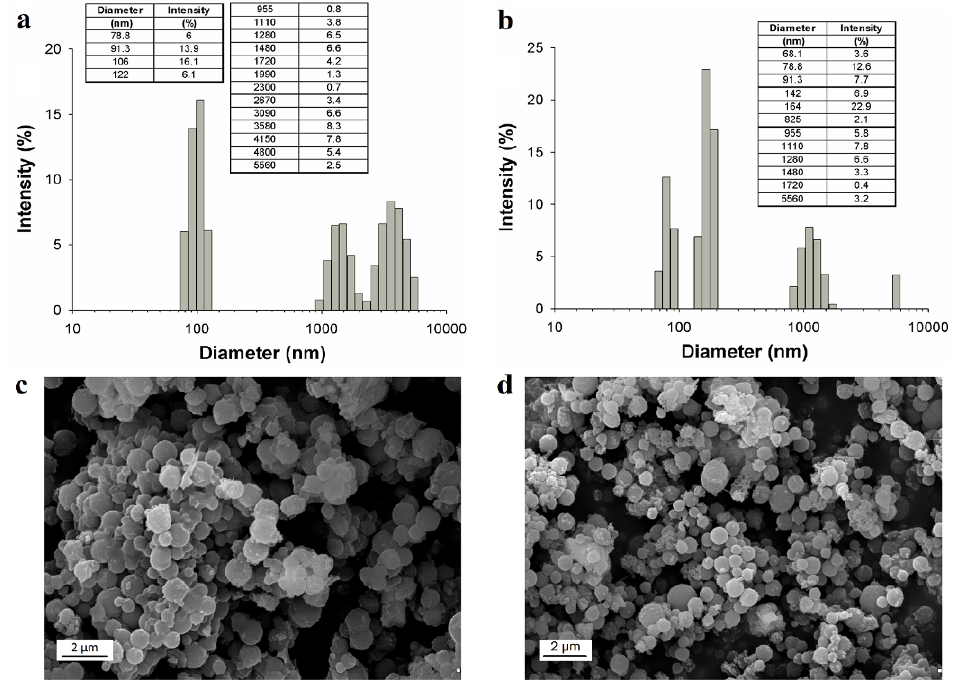
Figure 5. Particle size distributions measured on a Zetasizer Nano ZS and SEM images of (a, c) biocomposite 3 and (b, d) biocomposite